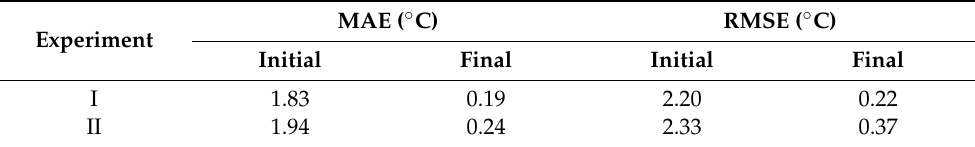
Figure 5. Inverted SST distribution I ( a ) and II ( b ) (unit: °C). Table 1. Quantitative metrics of ideal experiment results.